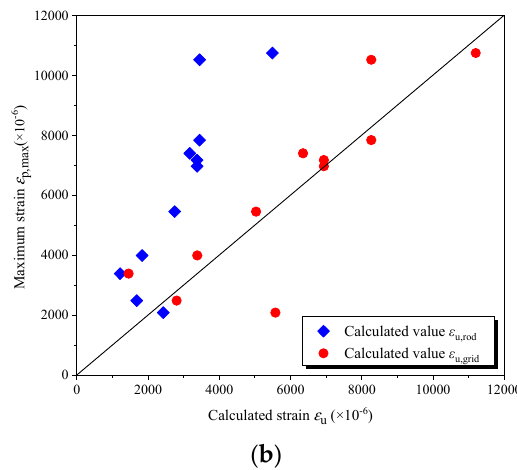
Figure 13. Comparison between the calculated and corresponding experimental values: ( a ) Comparison of shear capacity; ( b ) Comparison of CFRP grid strain.